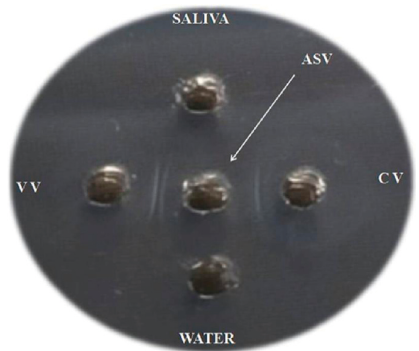
Figure 2: Immunodiffusion testing of venoms of Naja naja and Daboia russelii with commercially available polyvalent antiserum against Big Four. VV: viper venom (left well); CV: cobra venom (right well); ASV: antisnake venom (center